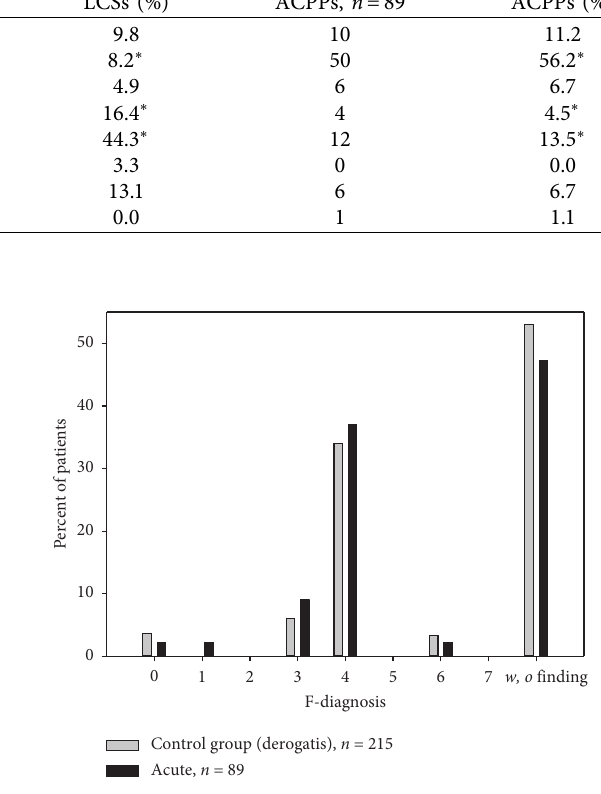
Figure 3: Distribution of psychiatric diagnoses (in percent) comparing ACPPs (acute cancer pain patients) and the historic control group (Derogatis et al. [22]). Light bar: control group- � psychiatric diagnosis in cancer patients according to Derogatis et al. [22] ( n � 215); dark bar: acute (ACPPs) ( n � 89); w / o finding: psychiatrically inconspicuous. F3-depressions in acute cancer patients � 9%; according to Derogatis et al. [22], 6.0%. The distri- bution of both groups is not significantly different (chi-square test, p � 0 .